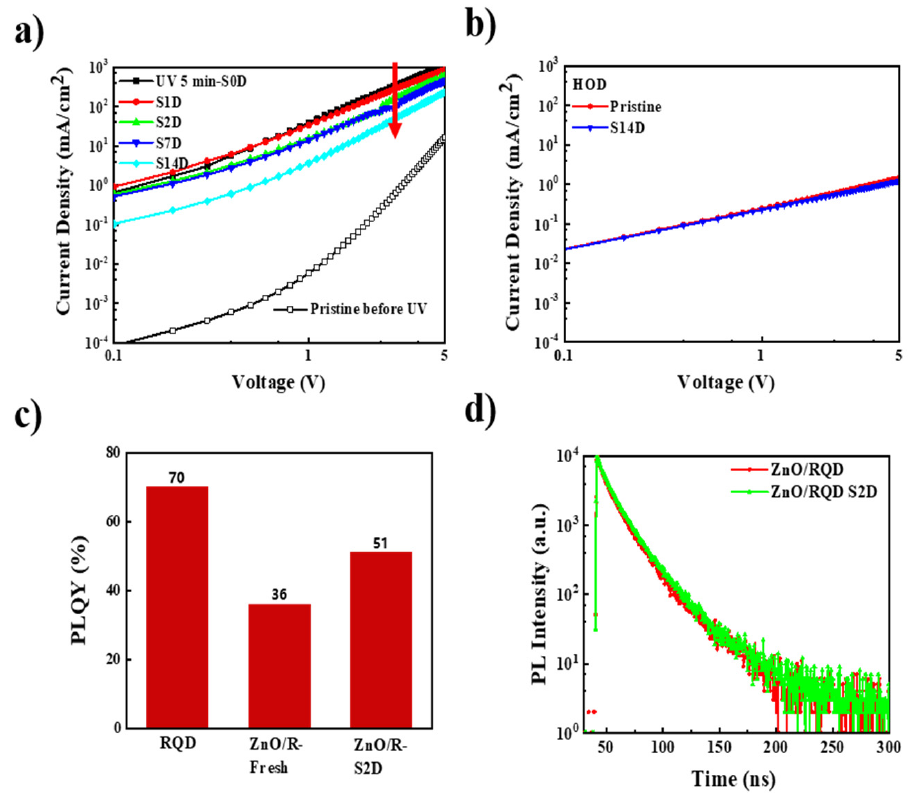
Figure 6. ( a ) J–V curves for the electron-only devices (ITO/ZnO/QDs/TPBi/LiF/Al) before and after storage from 0 to 14 days; ( b ) J–V curves for the hole-only devices before and after storage for 14 days; ( c ) the PLQY and ( d ) TRPL lifetime for the quartz/ZnO/QDs sample before and after storage for 2 days.